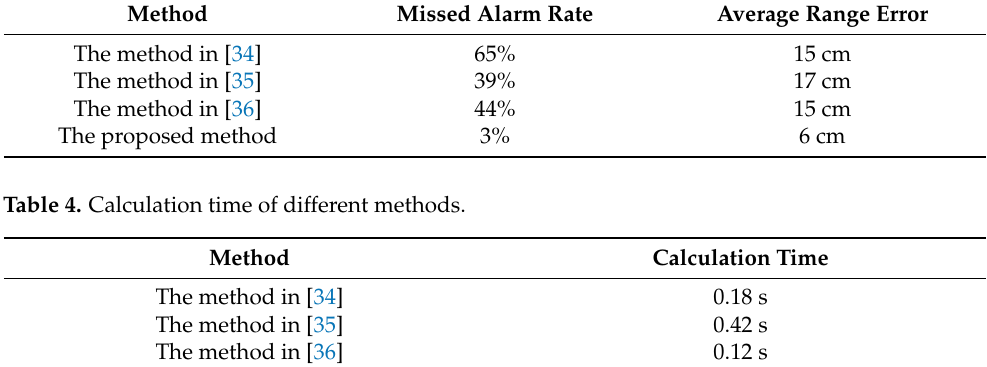
Table 3. Results of 50 sample data processed by different methods.